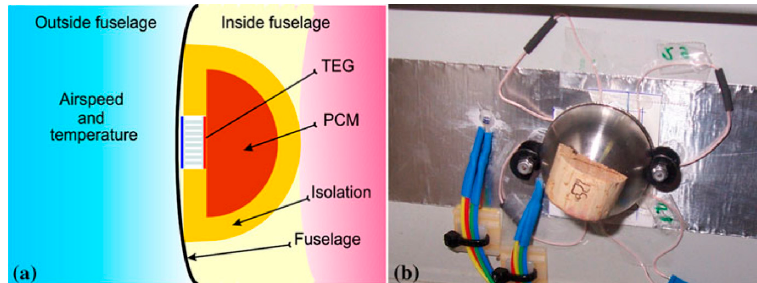
Figure 25. Static ( a ) and dynamic ( b ) TEG configurations used in airplanes’ fuselages [150].